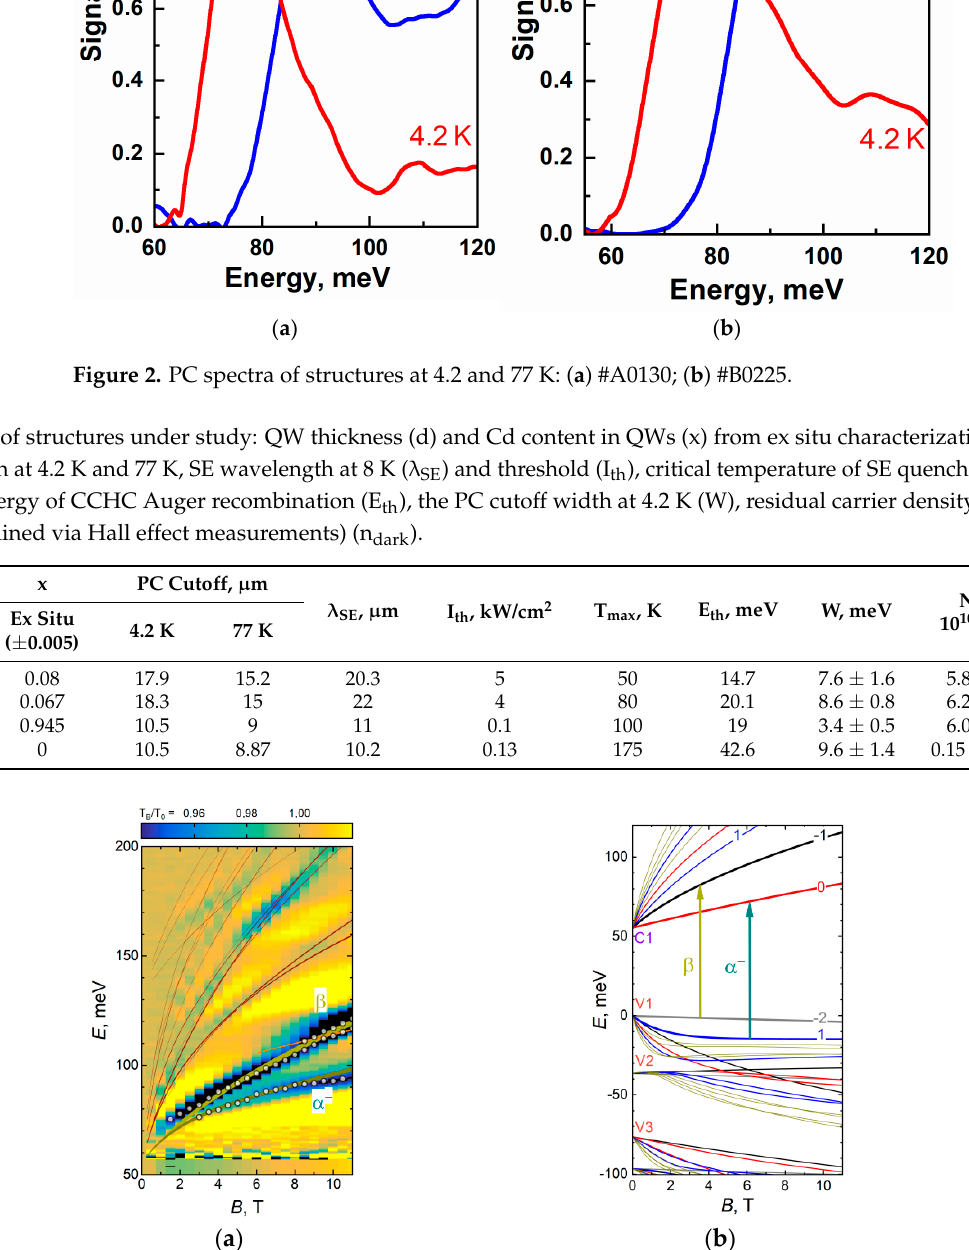
Figure 3. ( a ) Magneto-transmission of sample #A0130 at T = 4.2K plotted in the form of false-color plots with circles indicating the peaks of the particular absorption lines. The solid lines in the overlay correspond to the theoretically expected energies of the transitions; specific transitions β and α− are labeled. The thickness of the line reflects the probability of transition. Theoretical calculations provide the best fit for the rectangular quantum well Hg 0.92 Cd 0.08 Te with a thickness of 7.8 nm.( b ) Calculated Landau levels (LL) for a given structure; the arrows and Greek letters denote LL transitions, observed in the magneto-transmission spectra. Conduction and valence sub-bands are labeled on the left axis.